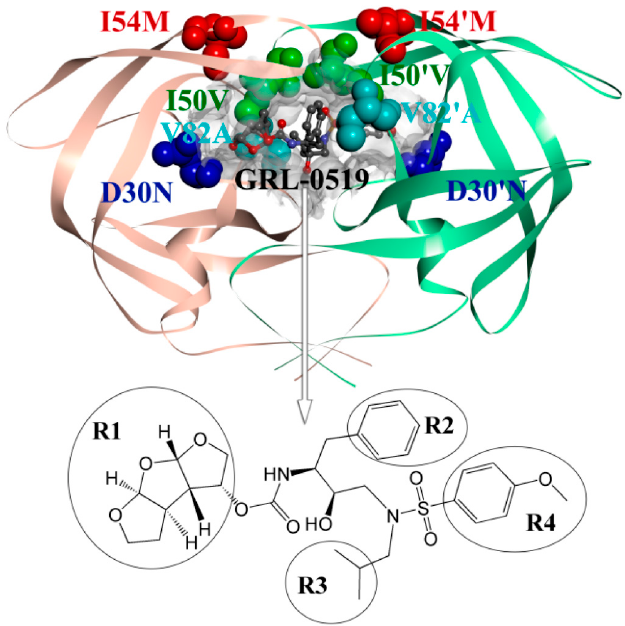
Figure 1. The locations of the four mutations in the wild type (WT). The PR is displayed in a solid ribbon representation, chain A is shown in light orange, chain B in pale green, GRL-0519 is displayed in a ball and stick representation, and the mutated residues are displayed as a ball with different colors as well as the labeled markers. The molecular structure of HIV-1 PR inhibitor GRL-0519 and the four groups (R1, R2, R3, and R4) are also shown.